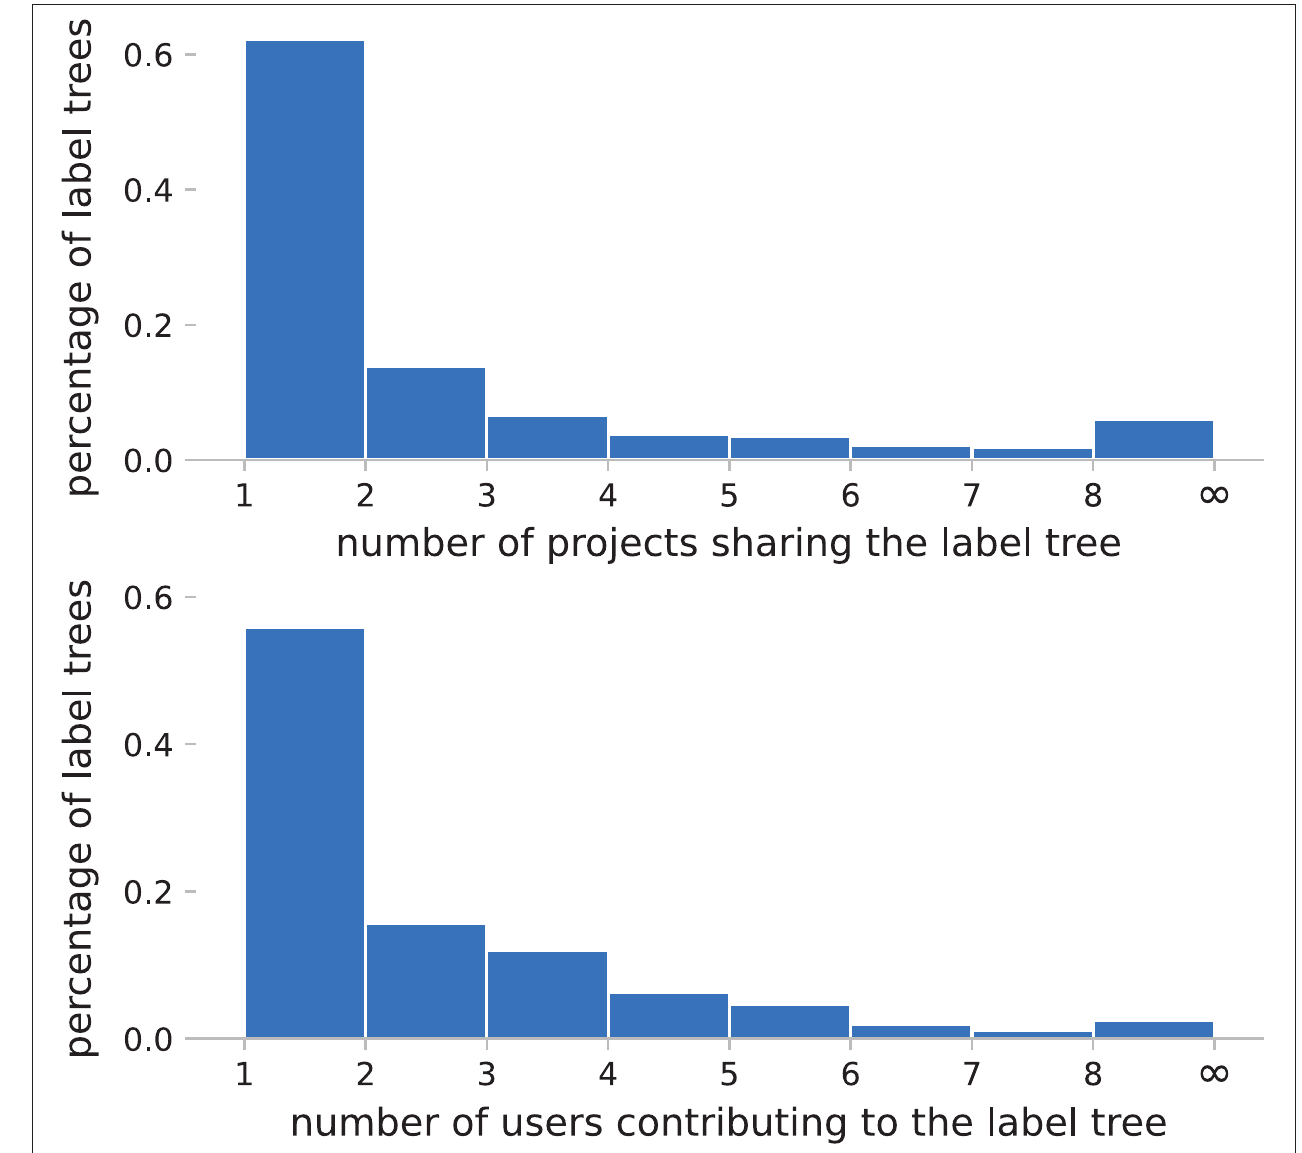
FIGURE 10 | Percentage of label trees on biigle.de, grouped by the number of projects sharing the label tree (top) and the number of users contributing to the label tree (bottom) . The majority of label trees is used by only a single project and is curated by only a single user. The following label trees were excluded for this figure: The global label tree attached to new projects by default, the label tree of the “demo” project, label trees without labels, label trees without project and label trees called “test”. frame that should be annotated in the video, compared to